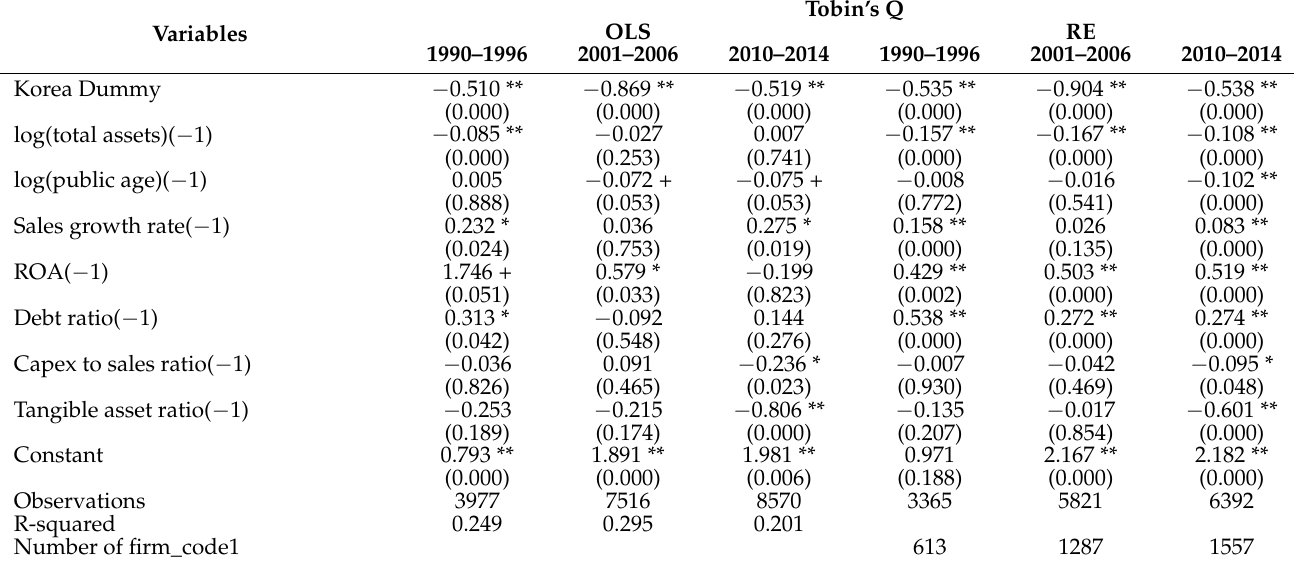
Figure 5. Comparison of firm value (Tobin’s Q). Table 6. Comparison of firm values (Tobin’s Q) by